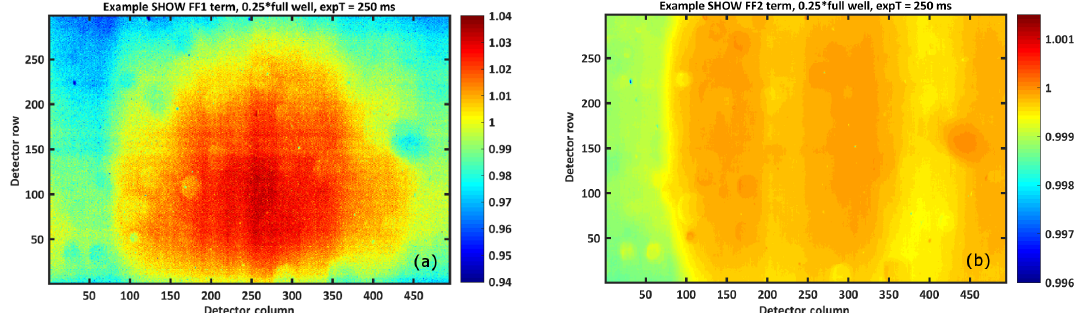
Figure 5. Example SHOW flat-field correction images obtained using a 250ms exposure time to obtain a quarter full well signal. The FF1 term is shown in (a) and the FF2 term is shown in (b)